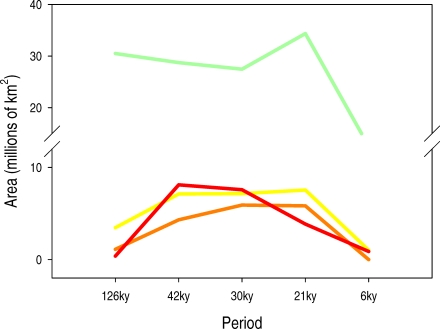
Change in the Area (%) of the Different Suitable Climatic Conditions for Woolly MammothsThe suitability of climatic conditions based on MD was split into quartiles (Q1, red; Q2, orange; Q3, yellow; Q4, green). Q1 represents the most suitable conditions and Q4 represents the less suitable. The extent of the most suitable conditions for woolly mammoths was smaller during warmer interglacial periods, 126 ky BP and 6 ky BP.